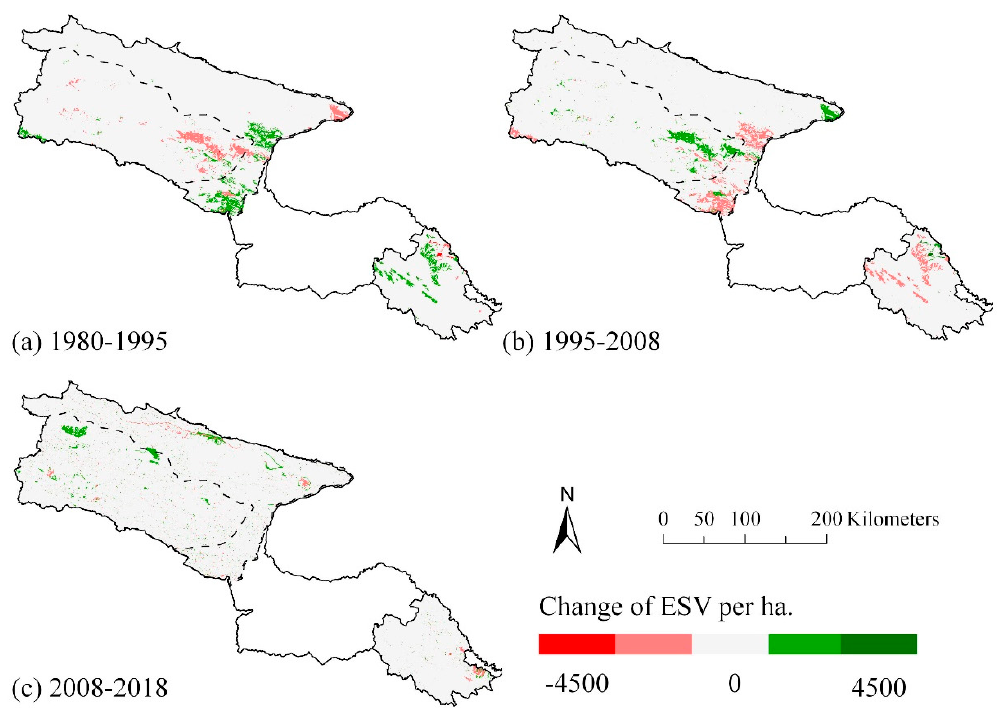
Figure 5. Comparison of the changes of ecosystem service value per unit in HXNR and the control